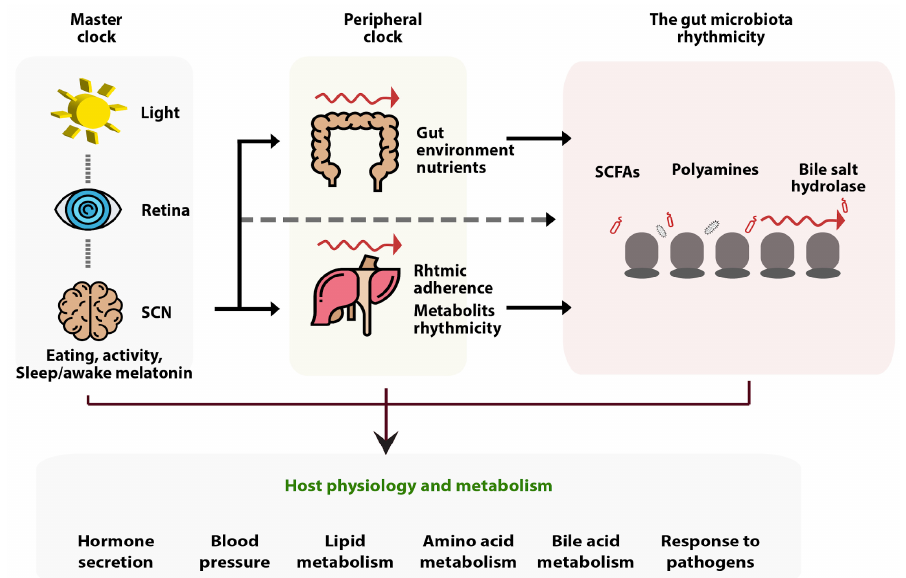
Figure 3. Schematic diagrams showing that to keep the host’s physiology and metabolism running at a regular rhythm, gut microbiota rhythm collaborates with the host’s circadian clock. Activities, such as habits and sleep/wake cycle, are driven by a master clock in the SCN, which is entrained by environmental stimuli, especially light stimuli, to synchronize with the environment’s regular variations. Abbreviations: suprachiasmatic nucleus (SCN); short-chain fatty acids (SCFA) [125].